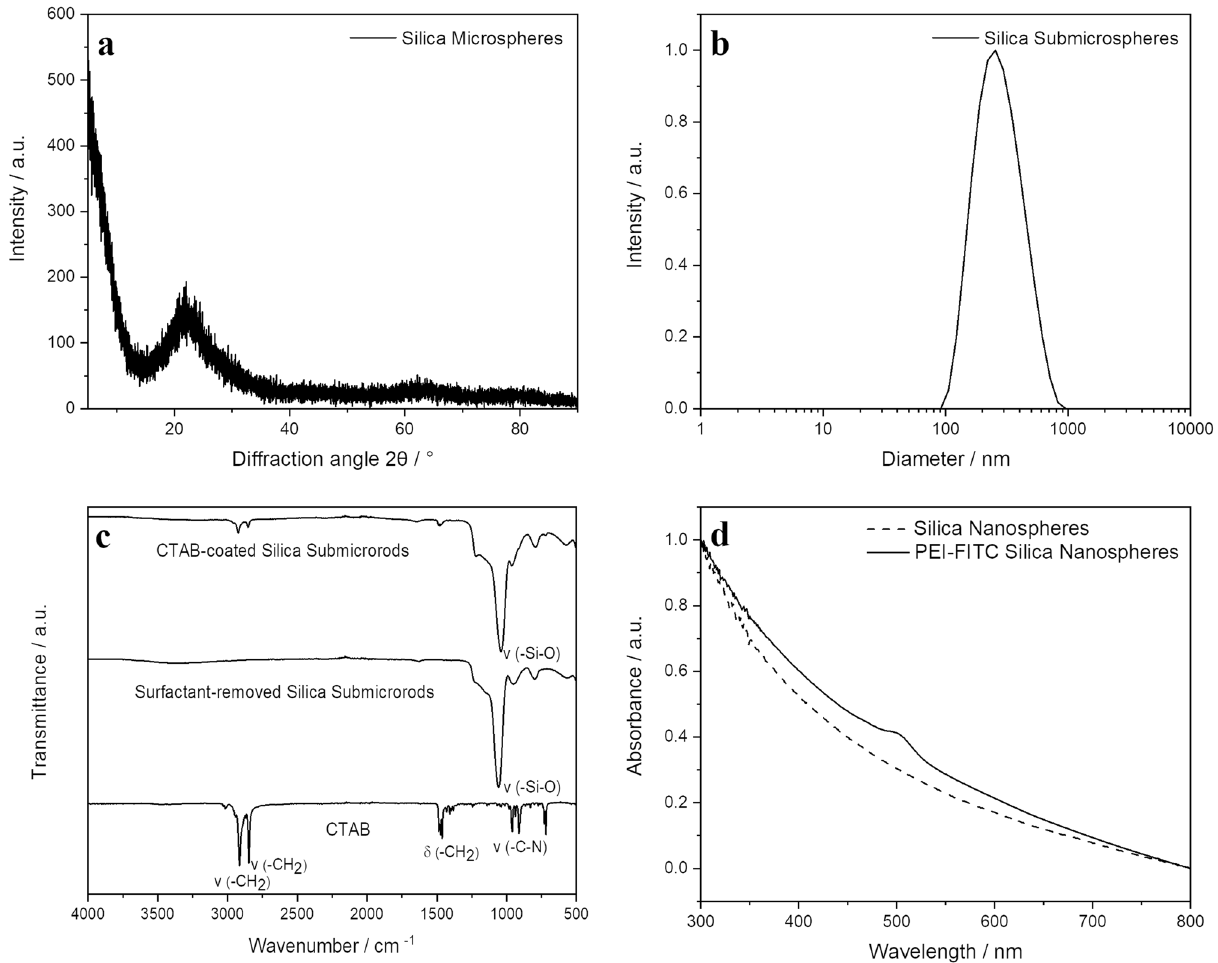
Figure 3. Representative characterization data of unfunctionalized silica particles ( a – d ) and for fluorescent silica particles ( d ): XRD shows amorphous particles ( a ), DLS shows well-dispersed particles ( b ), IR spectroscopy confirms the removal of CTAB after the synthesis ( c ), and UV/vis spectroscopy confirms the attachment of PEI- FITC ( d ). The particles with other morphologies had very similar properties.